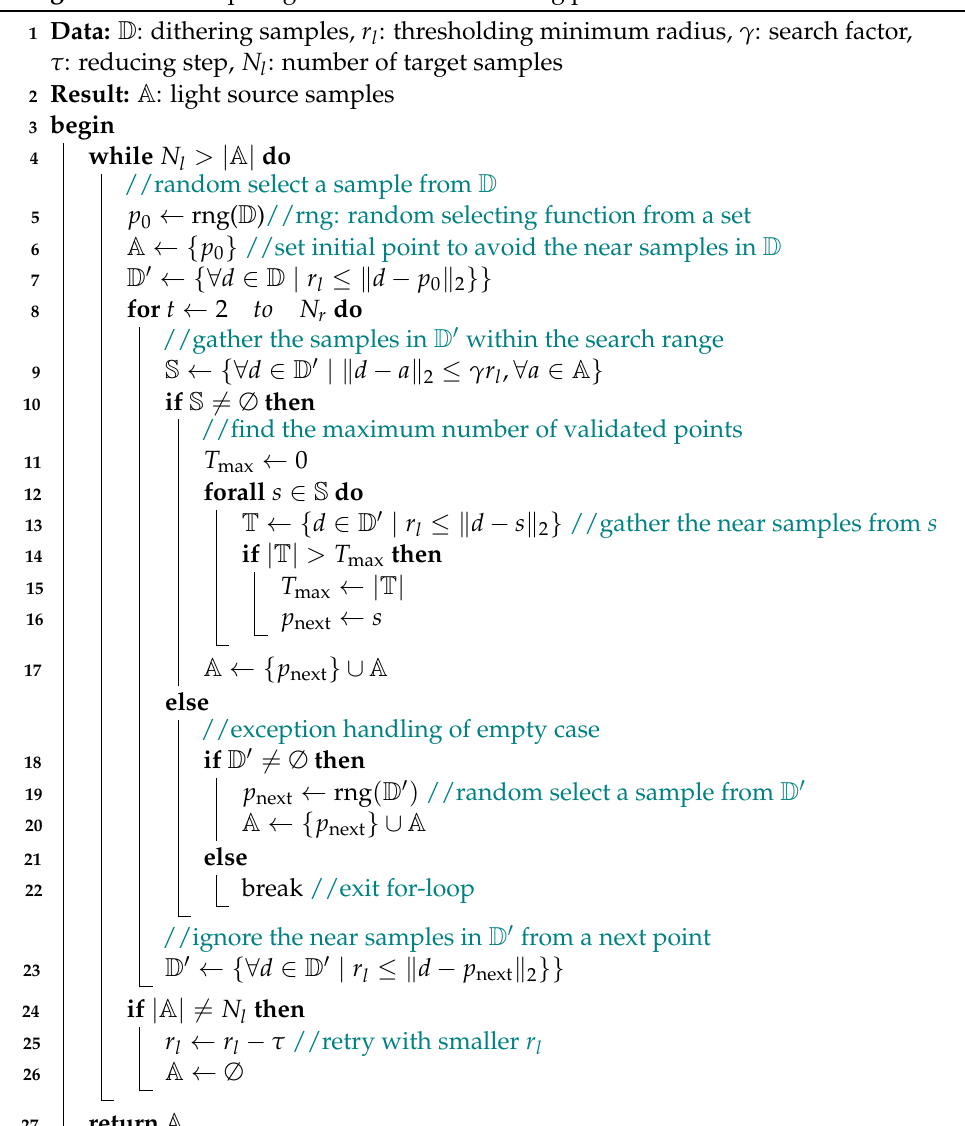
Algorithm 1: Sample light source from dithering